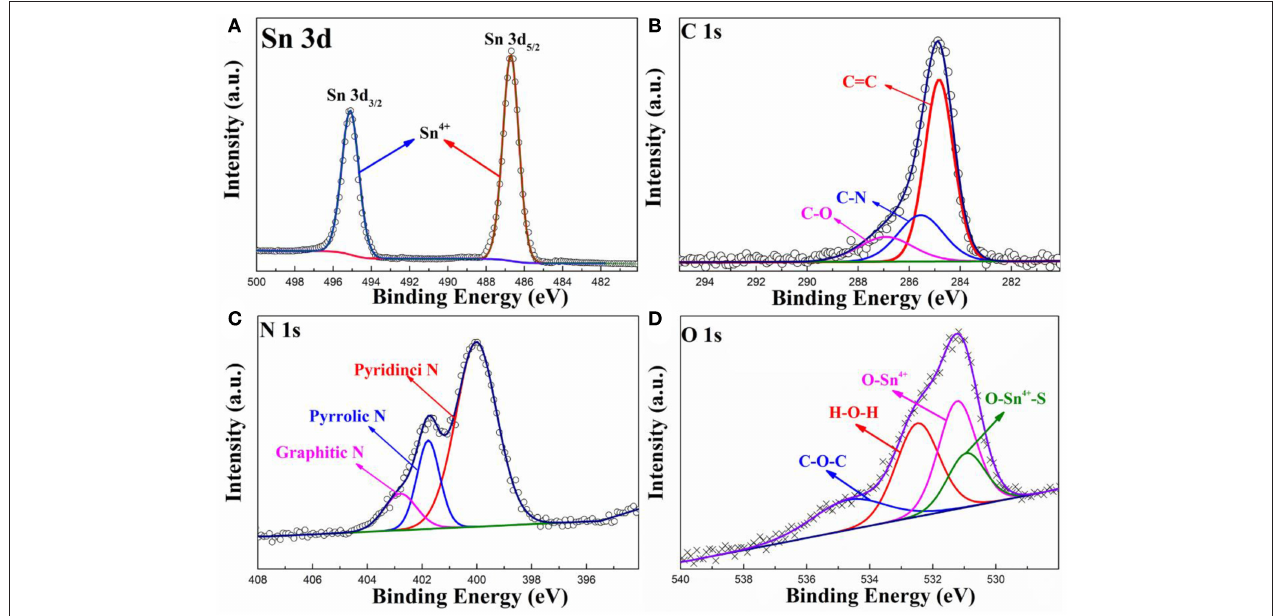
FIGURE 2 | High-resolution XPS spectra of (A) Sn 3d, (B) C 1s, (C) N 1s, and (D) O 1s spectra for SnO 2 -SnS 2 @C/NG composite.